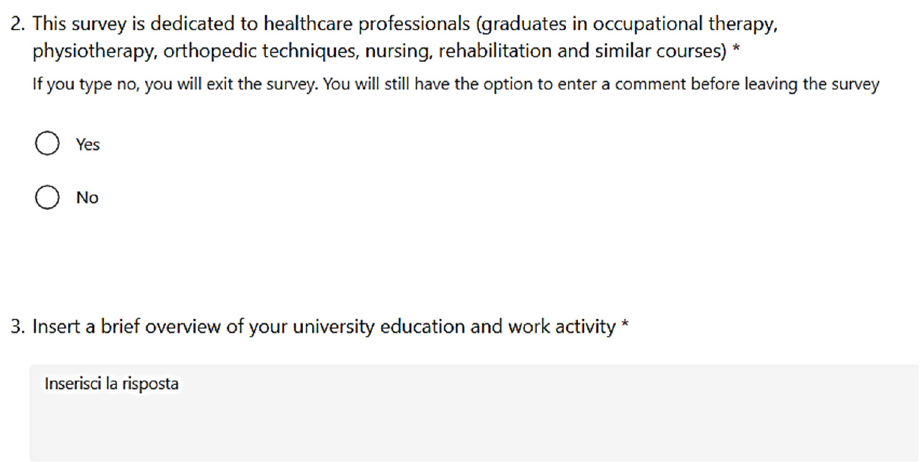
Figure 2. The section of the questionnaire dedicated to inclusion in the study. Table 1. Demographics